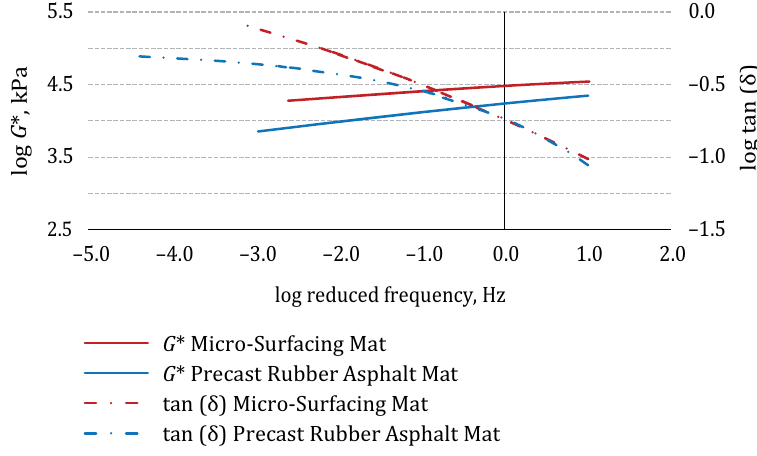
and of two different thin * tan (δ)